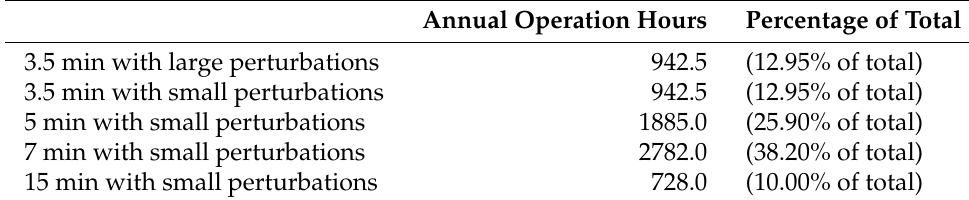
Table 1. Annual operation hours of the line under